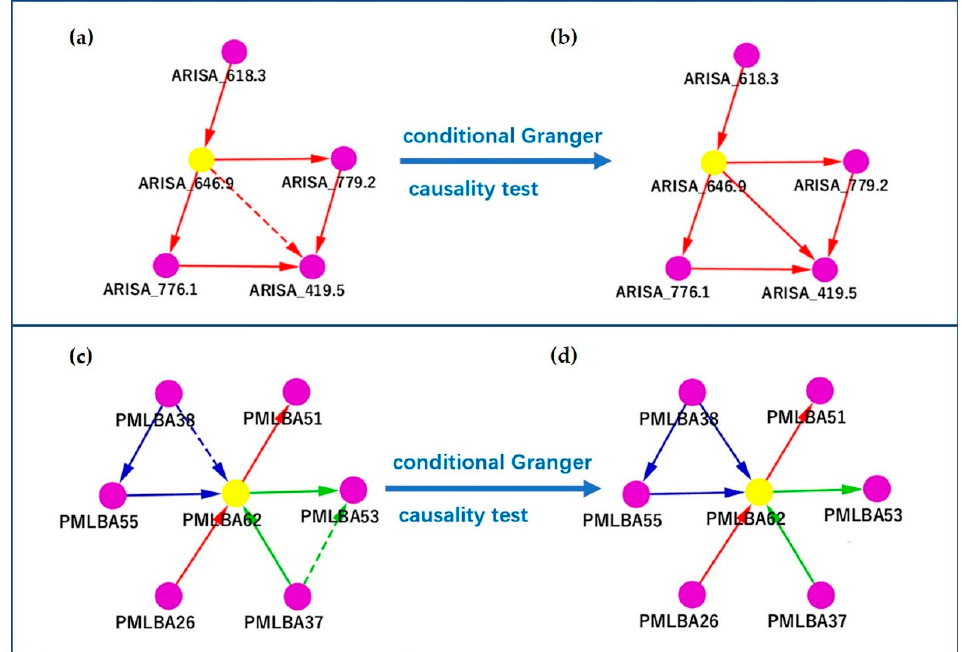
Figure 4. Examples of determining causal relationships using the conditional Granger causality. Shown are subnetworks centered at ARISA_646.9 and PMLBA62 based on SPOT and PML data respectively: ( a ) the subnetwork centered on ARISA_646.9 (before the conditional Granger causality test); ( b ) the subnetwork centered on ARISA_646.9 (after the conditional Granger causality test); ( c ) the subnetwork centered on PMLBA62 (before the conditional Granger causality test); ( d ) the subnetwork centered on PMLBA62 (after the conditional Granger causality test). A green square represents an environmental factor, including ChlA, Leu, SiO3, and Thy. A purple circle represents an OTU. A yellow circle represents a highlighted key OTU which was discussed in the main text.